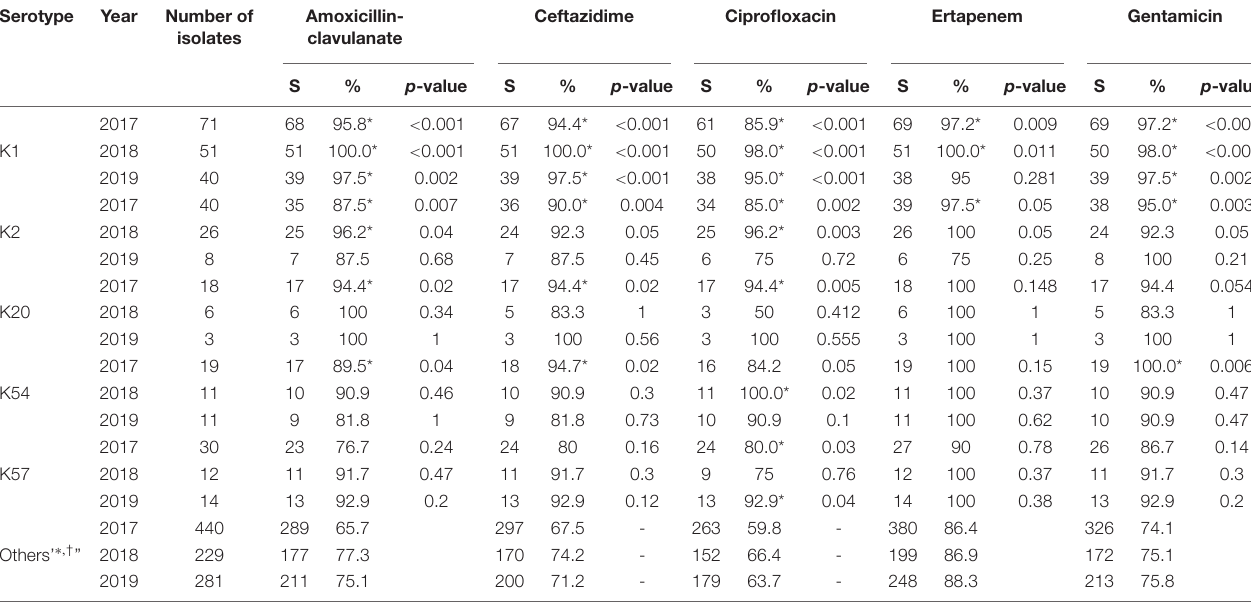
TABLE 4 | Antimicrobial susceptibility of main bacteremic Klebsiella pneumoniae serotypes.